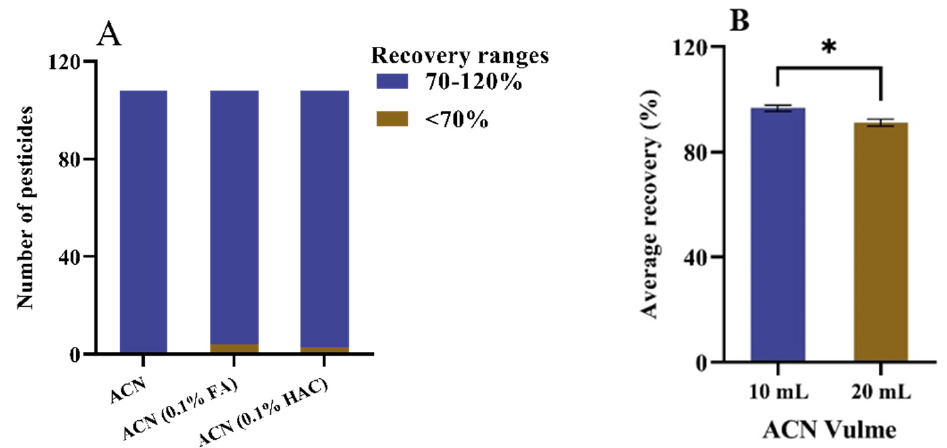
Figure 2. ( A ) Influence of extraction solvent on the recovery of the pesticides from the spiked 100 µ g/kg mixed sample. ( B ) Influence of extraction solvent volume on the average recovery of the pesticides from the spiked 100 µ g/kg mixed sample. “*” means that there was a significant difference between the groups of data at p level < 0.05.